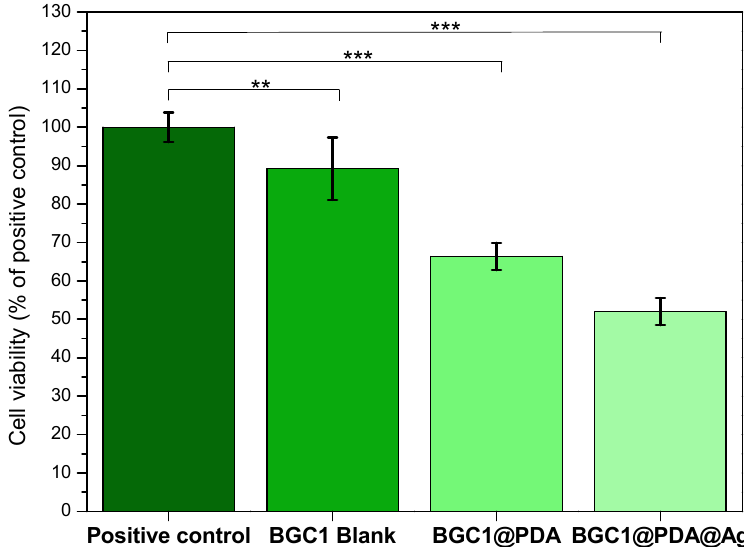
Figure 4. Viability of MG-63 cells cultured onto BGC1, BGC1@PDA and BGC1@PDA@Ag samples for 48 hours. Significant differences are indicated in comparison to control: * p < 0.05, ** p < 0.01 and *** p < 0.001 (Tukey’s posthoc test).